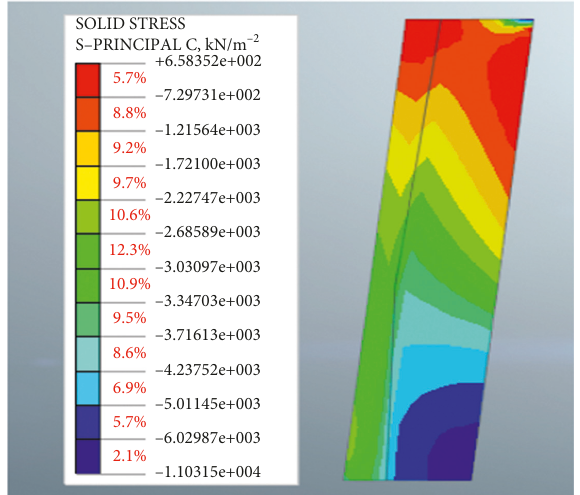
Figure 9: Horizontal displacement of the rock column at a mining depth of 300 m.